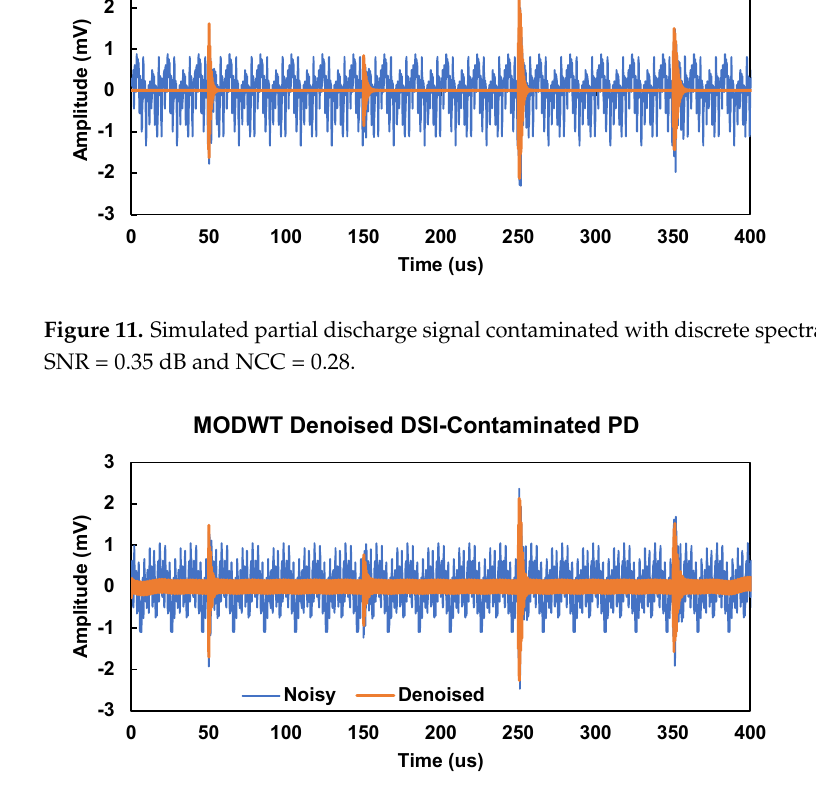
Figure 12. Denoised signal while contaminated with discrete spectral interference using MODWT.